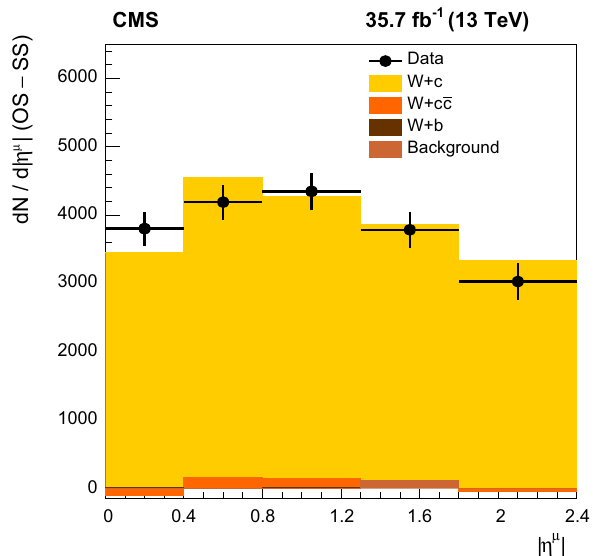
Fig. 3 Number of events after OS − SS subtraction for data (filled circles) and MC simulation (filled histograms) as a function of | η μ